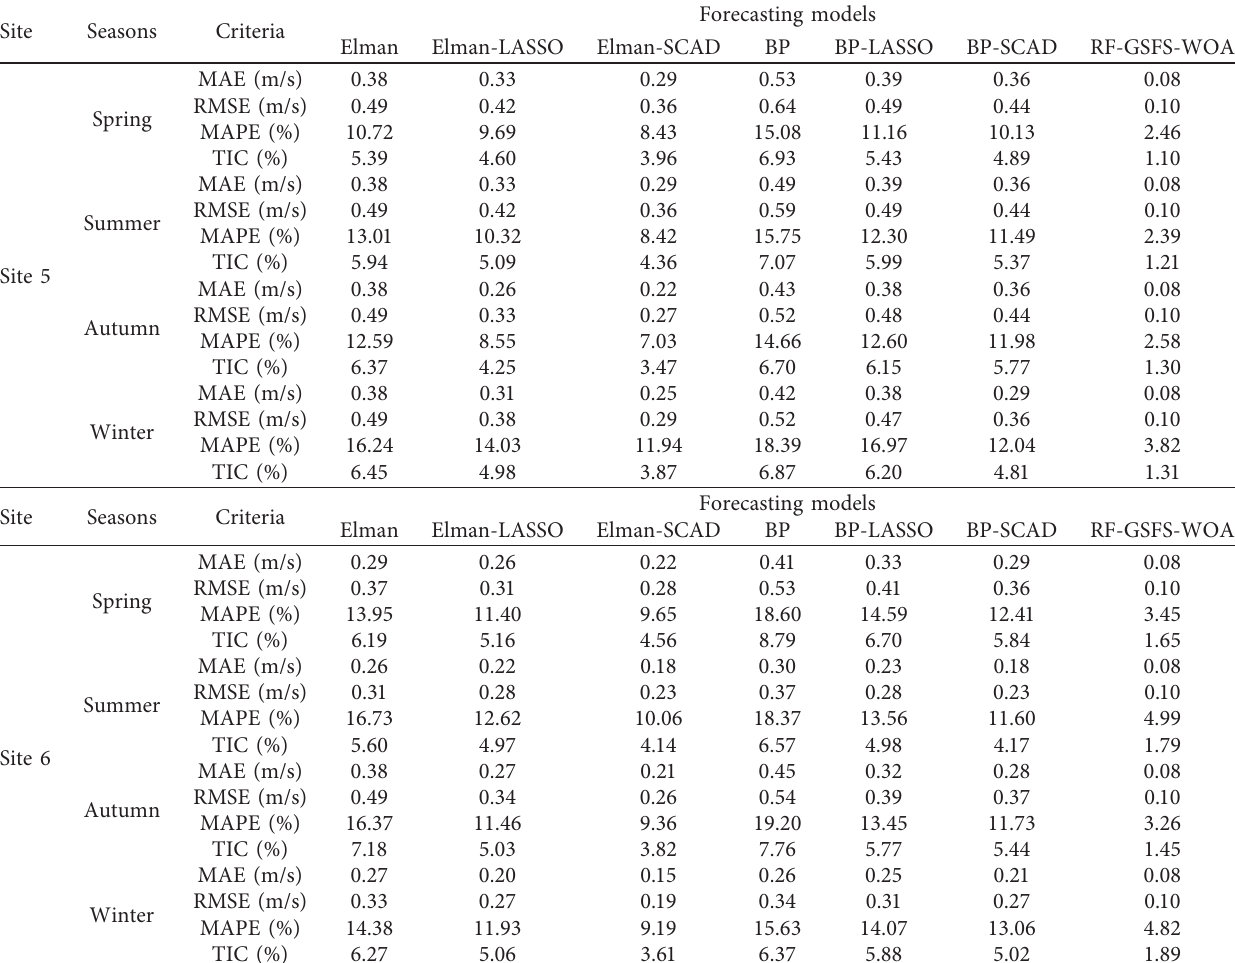
Table 5: Forecasting performances of the proposed model and other models in four seasons at Site 5 and Site 6.